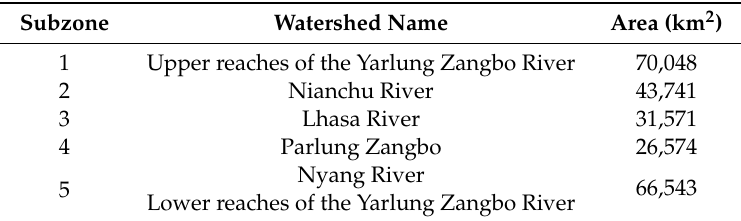
Table 1. Name and area of the subzone.